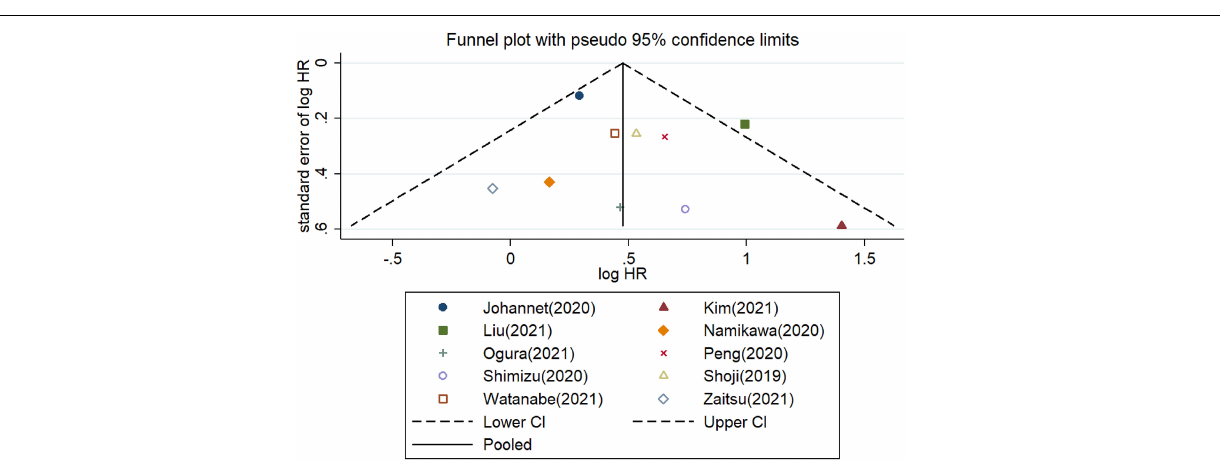
FIGURE 6 | Meta-analysis of impact of PNI on immune-related adverse events in patients treated with immune checkpoint